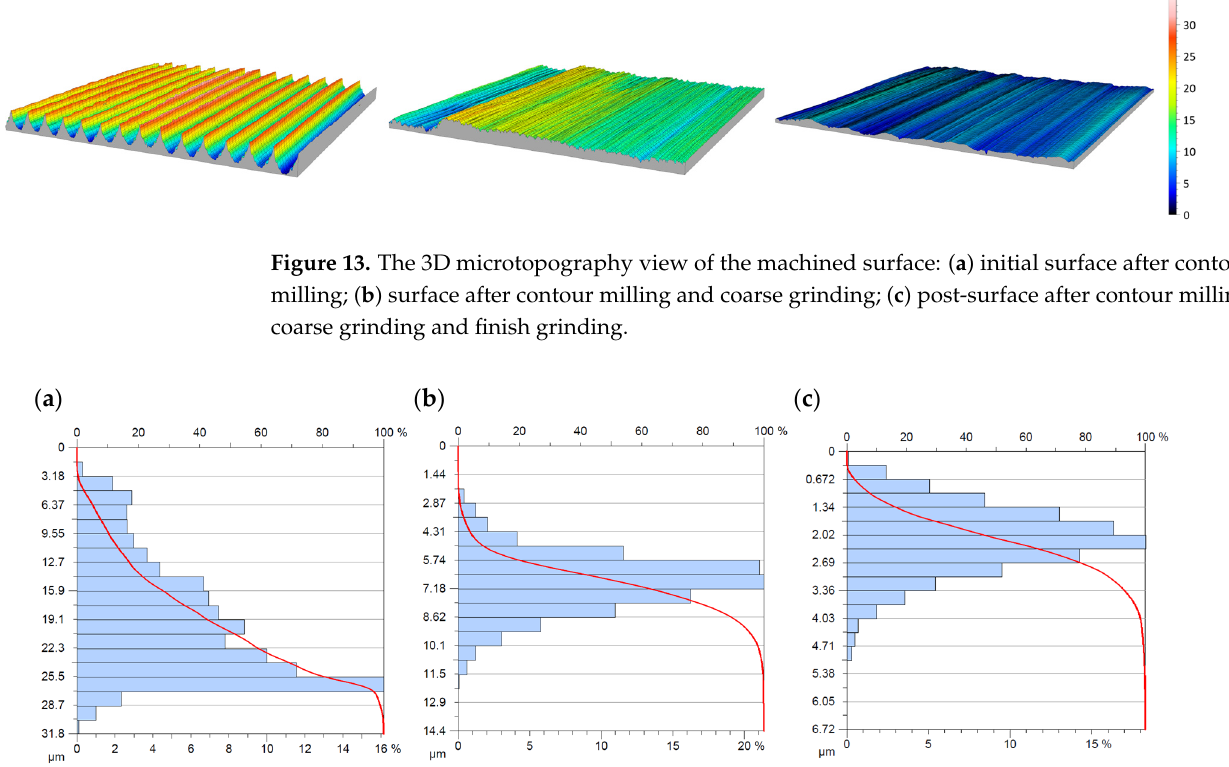
Figure 13. The 3D microtopography view of the machined surface: ( a ) initial surface after contour milling; ( b ) surface after contour milling and coarse grinding; ( c ) post-surface after contour milling, coarse grinding and fi nish grinding.